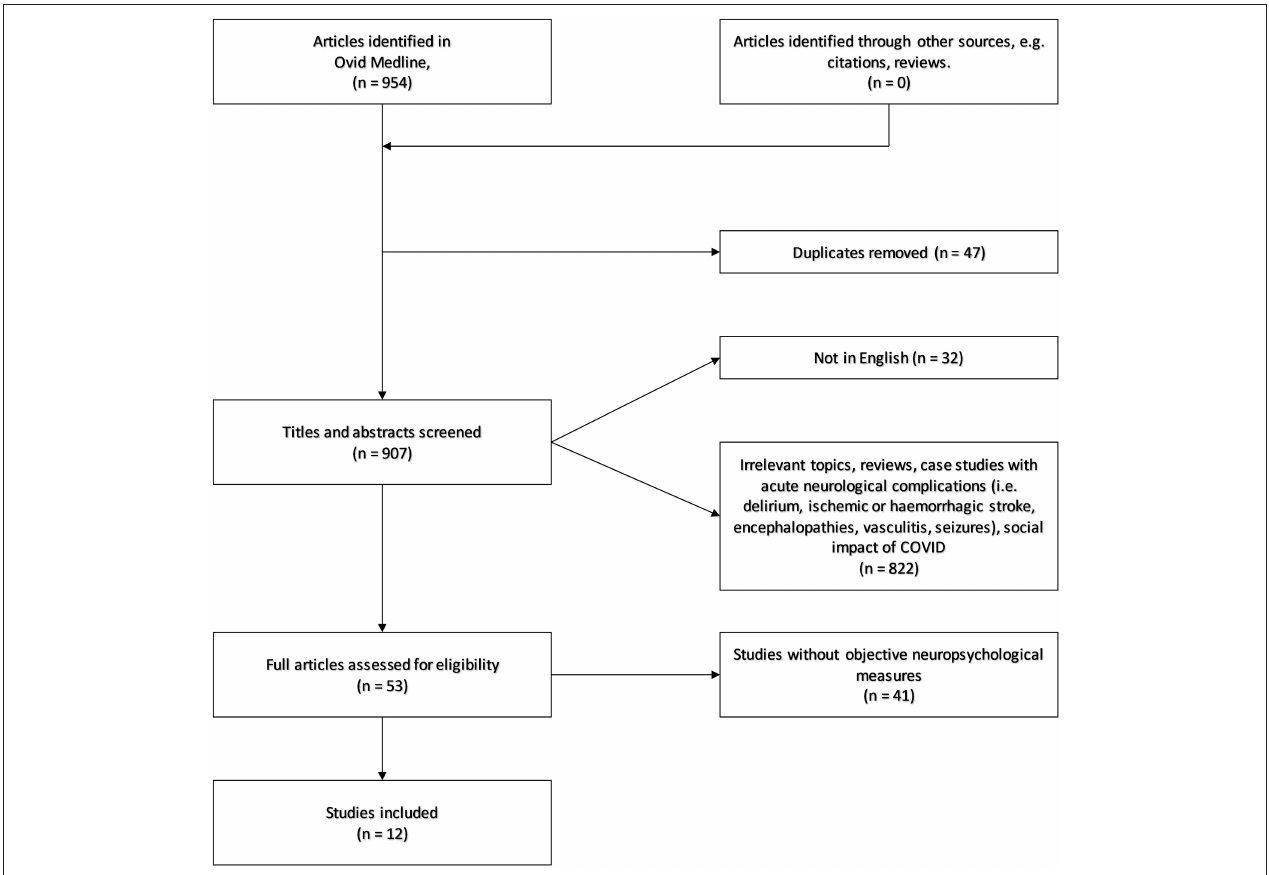
FIGURE 1 | Flow chart for inclusion and exclusion of